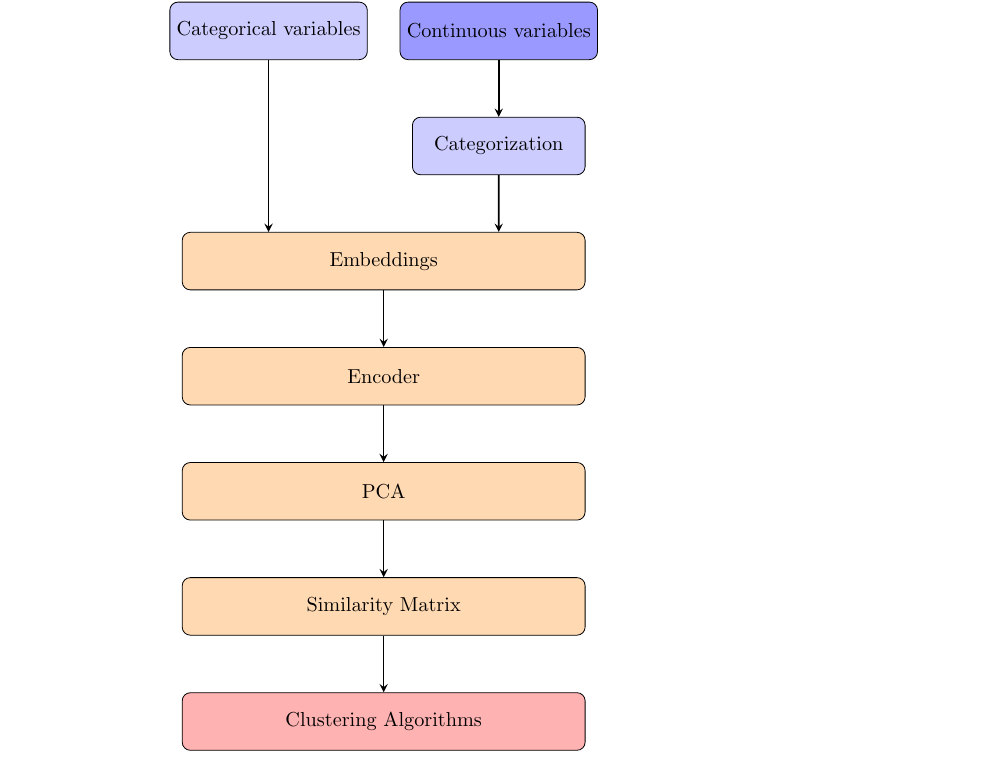
Figure 2. Proposed methodology of clustering data containing categorical